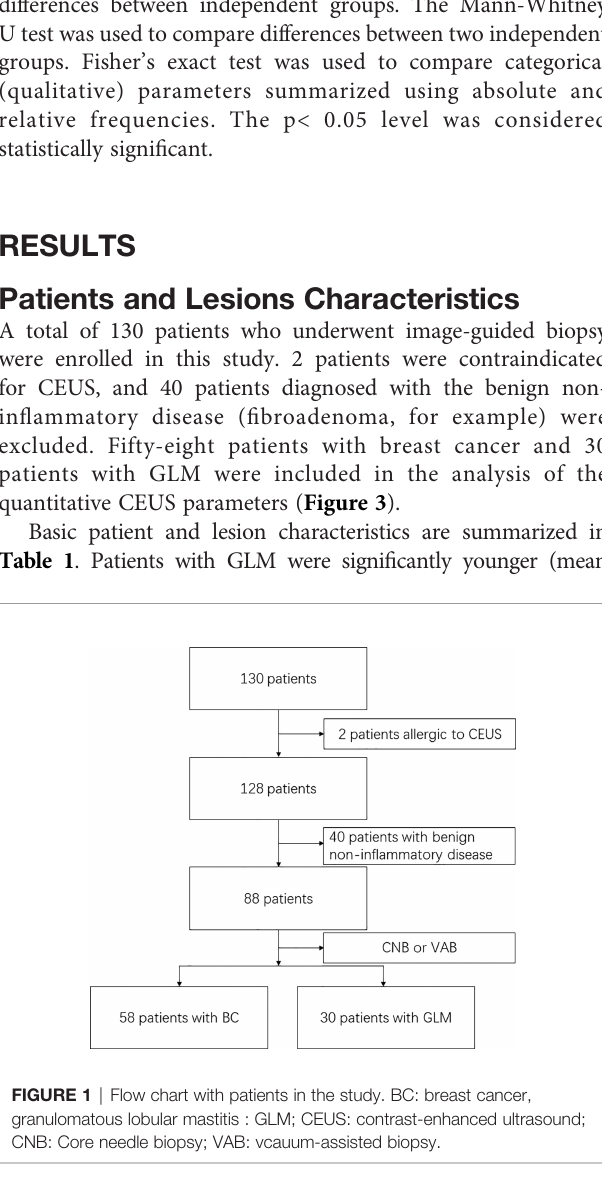
FIGURE 1 | Flow chart with patients in the study. BC: breast cancer, granulomatous lobular mastitis : GLM; CEUS: contrast-enhanced ultrasound; CNB: Core needle biopsy; VAB: vcauum-assisted biopsy.